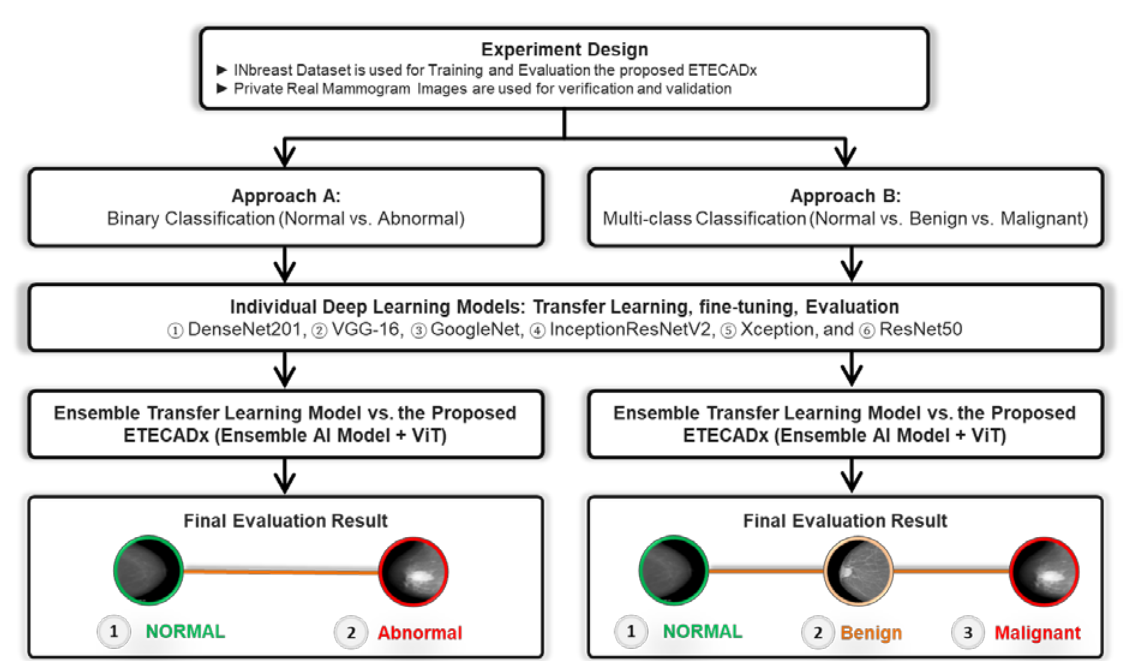
Figure 6. Experimental Study Scenario: Approach A and Approach B.